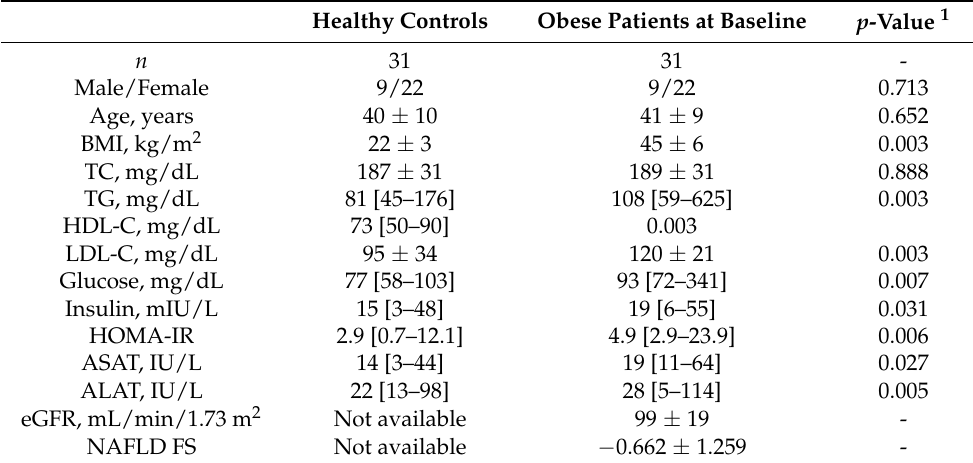
Table 1. Clinical characteristics of the subjects at baseline.